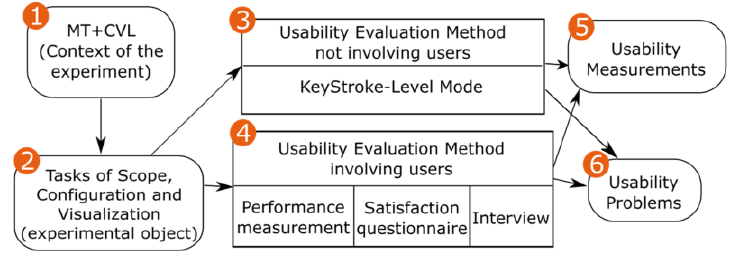
Figure 6. Overview of the Experimental